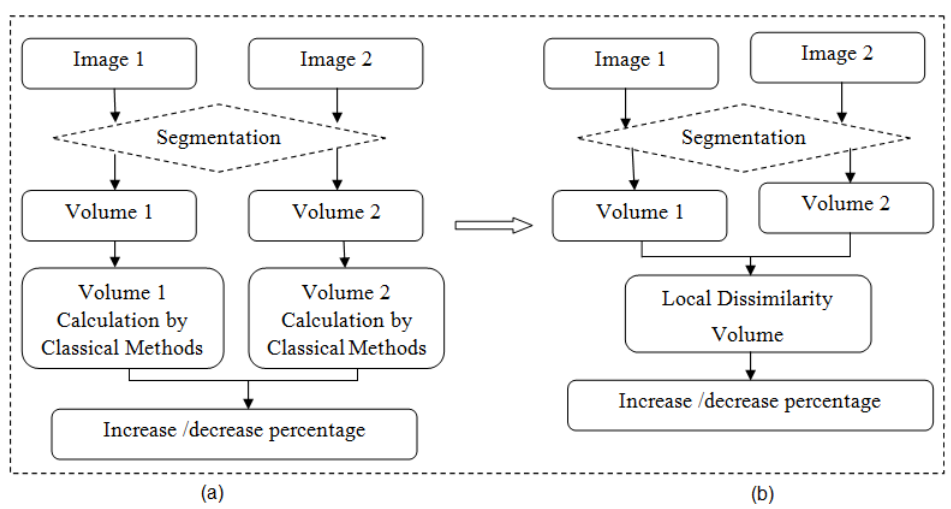
Figure 2. Novel approach of volume calculation using the local dissimilarity volume. ( a ) Classical approach for volume calculation; ( b ) Proposed method.